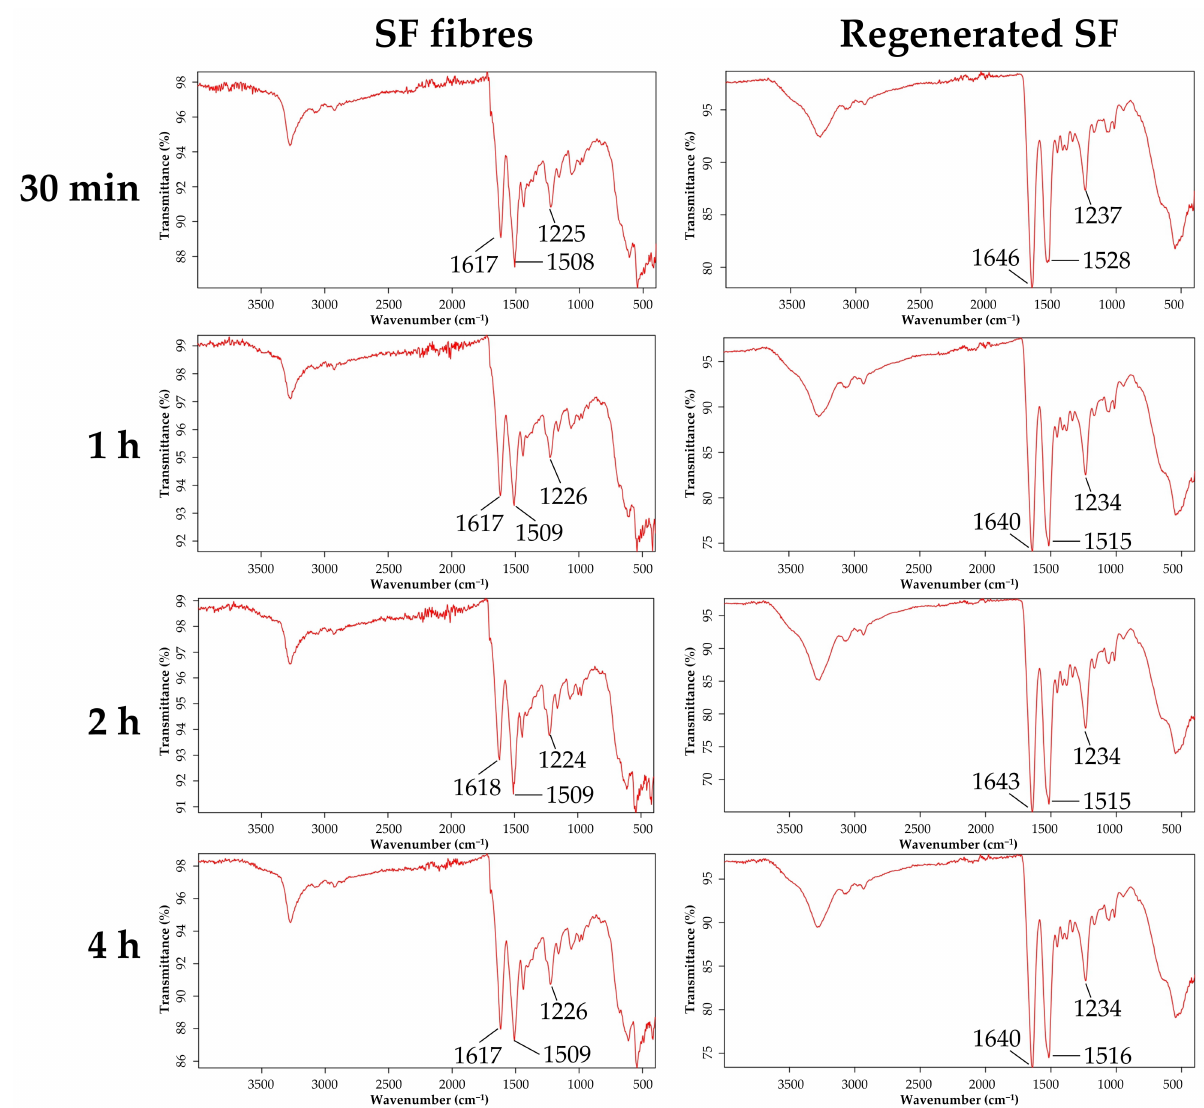
Figure 2. Infrared spectra of SF fibers degummed for 30 min, 1, 2, and 4 h, respectively, and regenerated SF treated with KCl 20% w / v